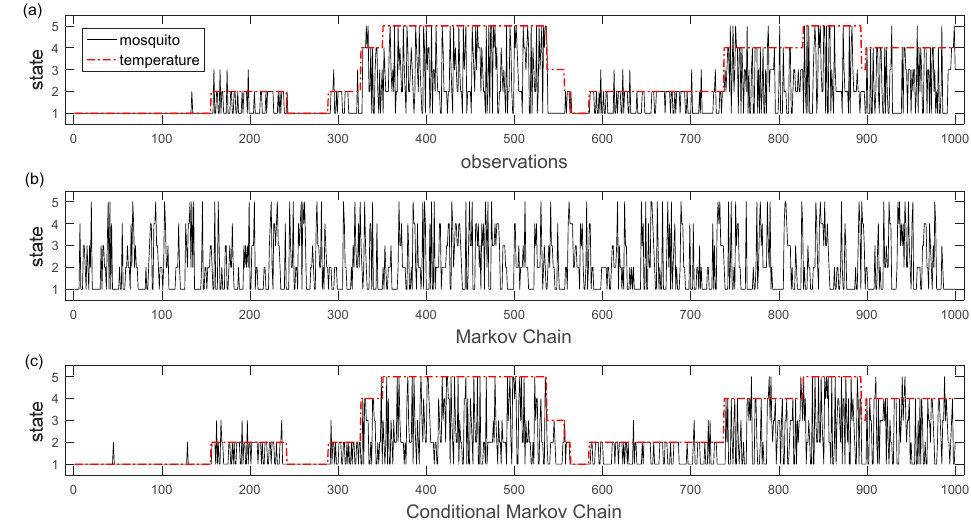
Figure 5. ( a ) Long term sequence of observation of the mosquito population process having five states (straight black line) and the process of a large scale temperature having five states (red dash—dotted line), respectively, and acting as background variable ( b ): realization of a Markov chain trained model on these observations and ( c ) realization of a conditional Markov chain trained on these observations (State 1: very low mosquito population or temperature levels, state 2: low mosquito population or temperature levels, state 3: moderate mosquito population or temperature levels, state 4: high mosquito population or temperature levels, state 5: very high mosquito population or temperature levels). Each time period corresponds to an observation for a finite number of successive seasons. The initial state at time 0 corresponds to the first observation made.